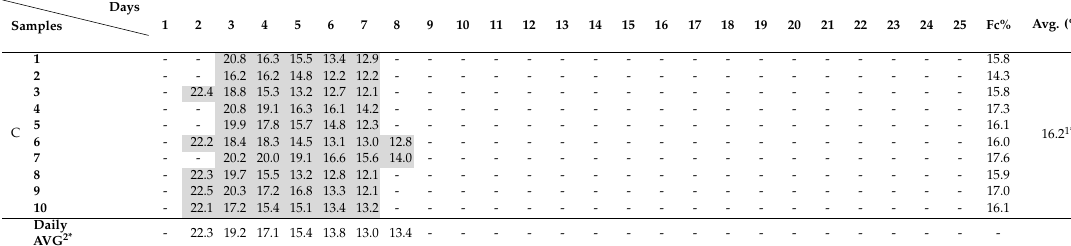
Table 13. Filler content measurement result (specimen C).